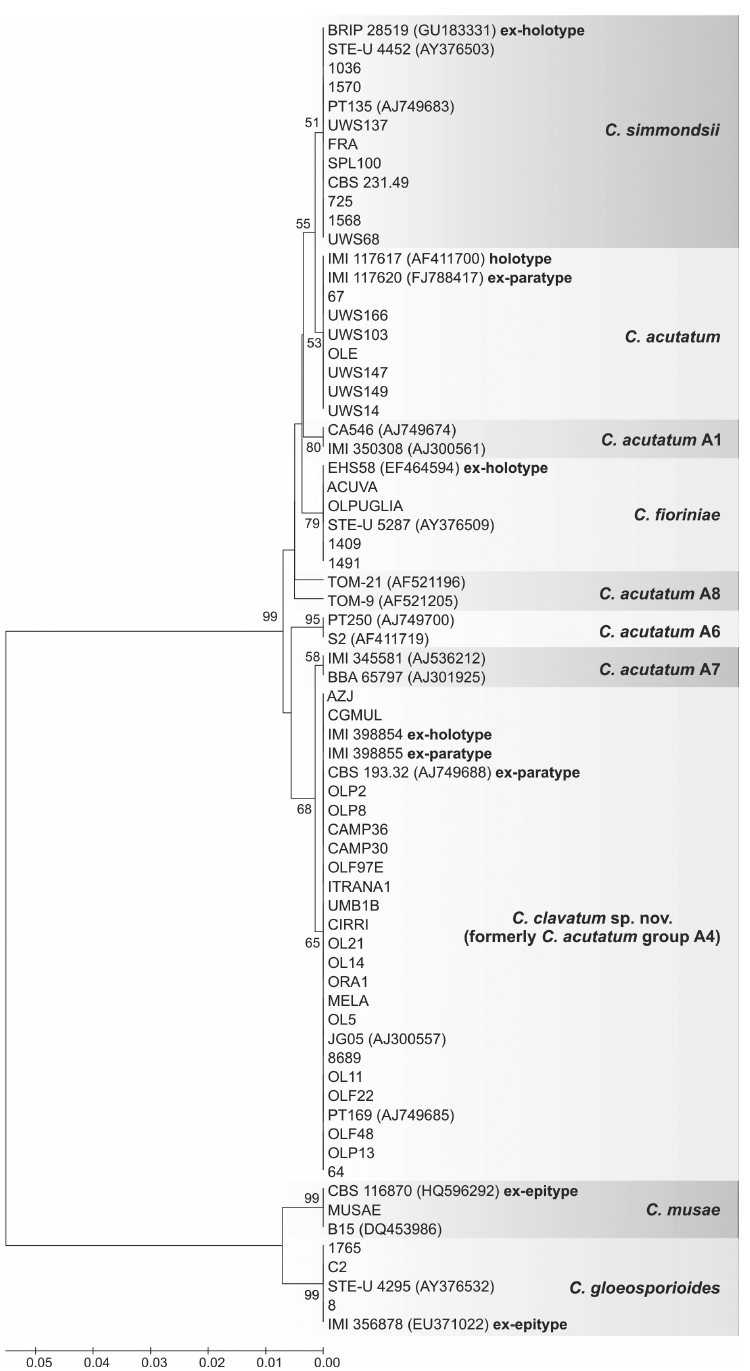
Figure 2. UPGMA phylogenetic tree of Colletotrichum based on ITS1-5.8S-ITS2 of ribosomal DNA, showing the po- sition of C. clavatum sp. nov. in relation to other known Colletotrichum species and genetic groups of C. acutatum . Bootstrap interior-branch values (1,000 replicates) ≥ 50% are displayed between the nodes. The GenBank accession numbers of the reference sequences are in brackets preceded by the corresponding isolate codes. The scale bar indi- cates a 0.001 U of genetic distance from Kimura’s two-parameter